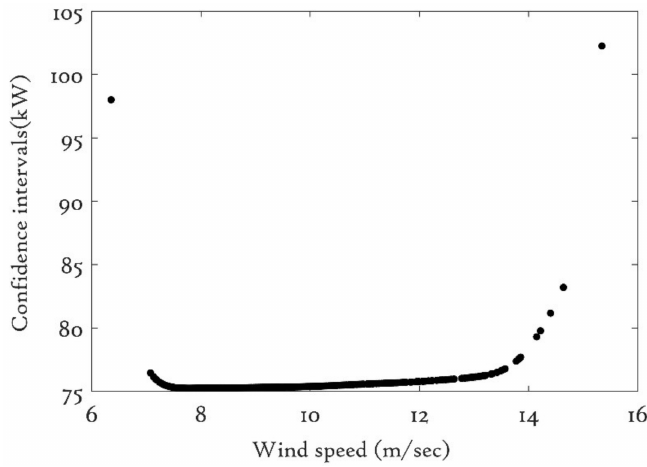
Figure 13. GP power curve uncertainty.